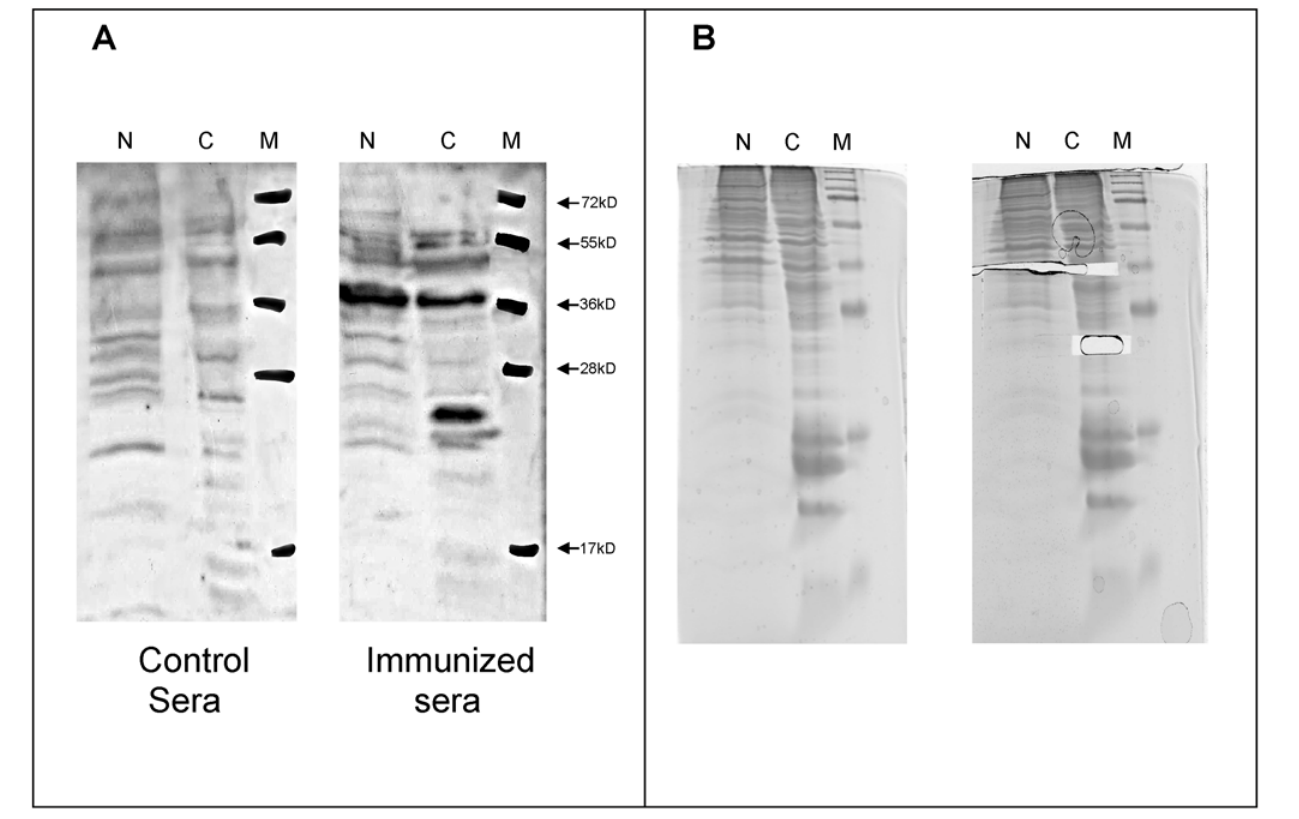
Fig 3. Identification of the corresponding antigen to the peptide sequence GPGRAPI. Protein isolates of the human urothelial cancer bladder cell line T24 was harvested, lysed and fractionated. (N = nuclear, C = cytosolic fraction, M = protein marker). A) Western Blot, stained with preimmune (left gel) and the immunized (right gel) rabbit serum. B) Corresponding gel before (left gel) and after excision (right gel) of the recognized bands for MALDI